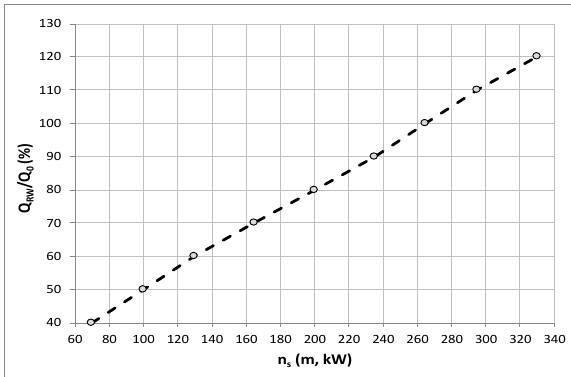
Figure 4. Overspeed effect on the discharge variation ( Q RW / Q 0 ) of reaction turbines (adapted from [6,35]).